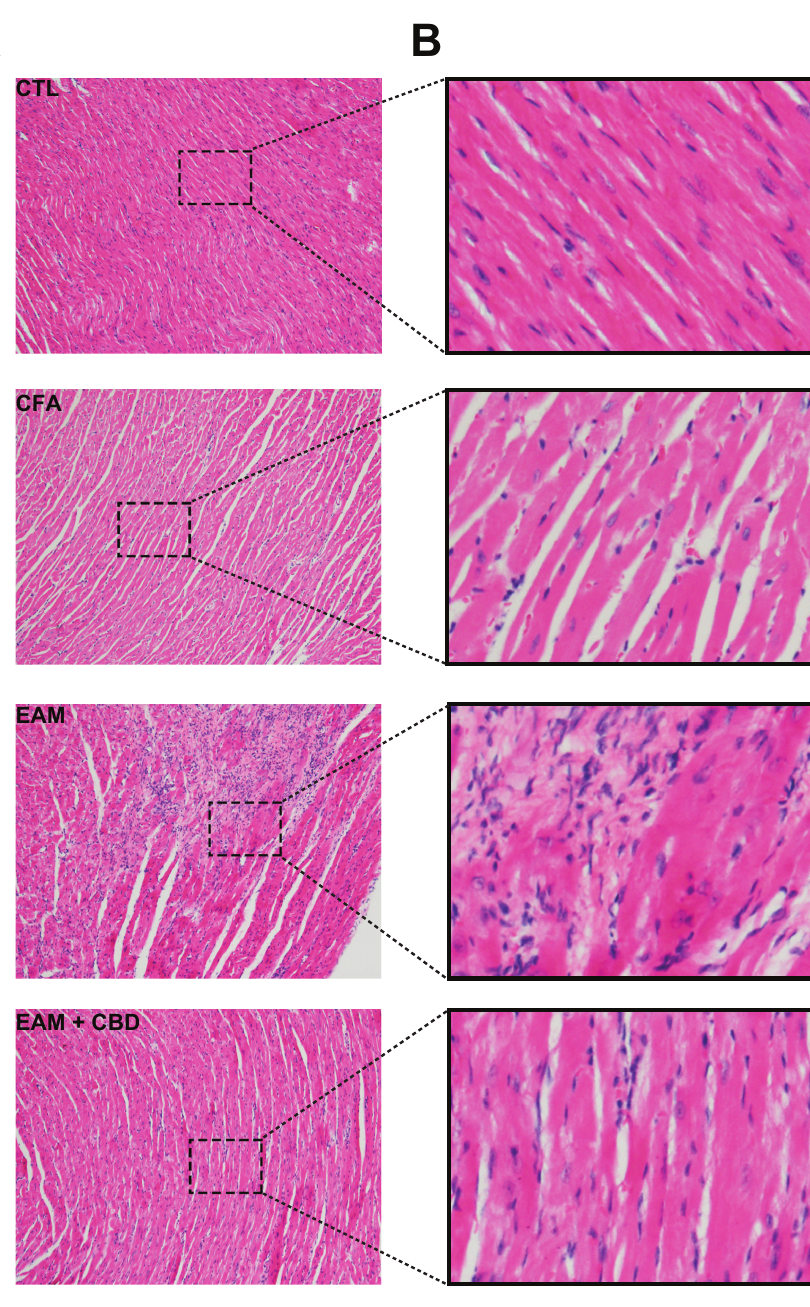
Figure 1. Effect of CBD on inflammatory cell invasion of the left ventricular myocardium. (A) Representative images of H&E-stained sections of the left ventricle. Magnification: 100×. (B) Representative areas from H&E-stained section with 400×